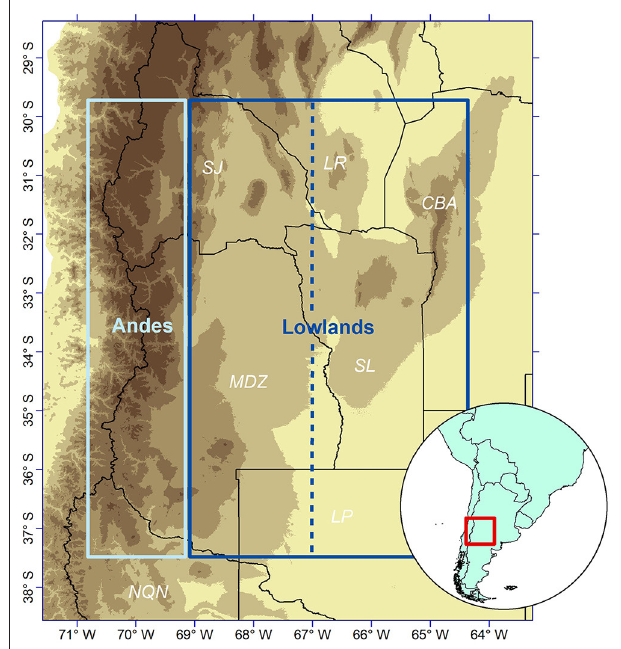
FIGURE 1 | Study area with the delimitation of the main regions analyzed (Andes and Lowlands) and the provinces included in the CWA. CBA, Córdoba; LP, La Pampa; LR, La Rioja; MDZ, Mendoza; NQN, Neuquén; SJ, San Juan; SL, San Luis. The dashed line divides the Eastern and Western portions of the Lowlands